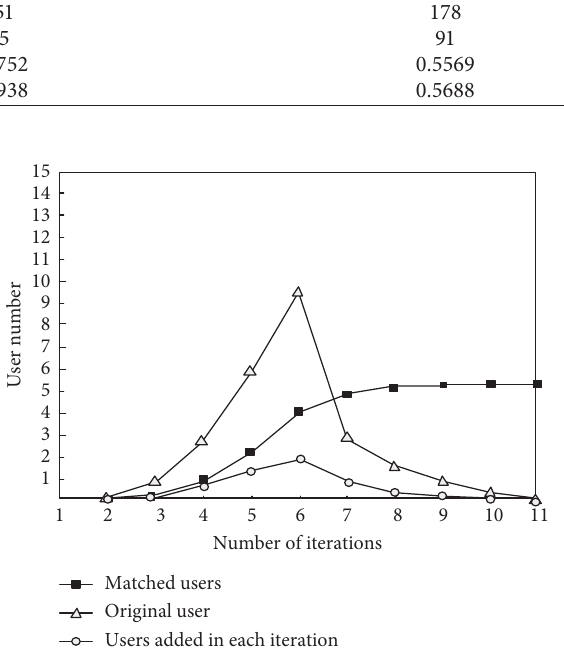
Figure 3: User association model operation